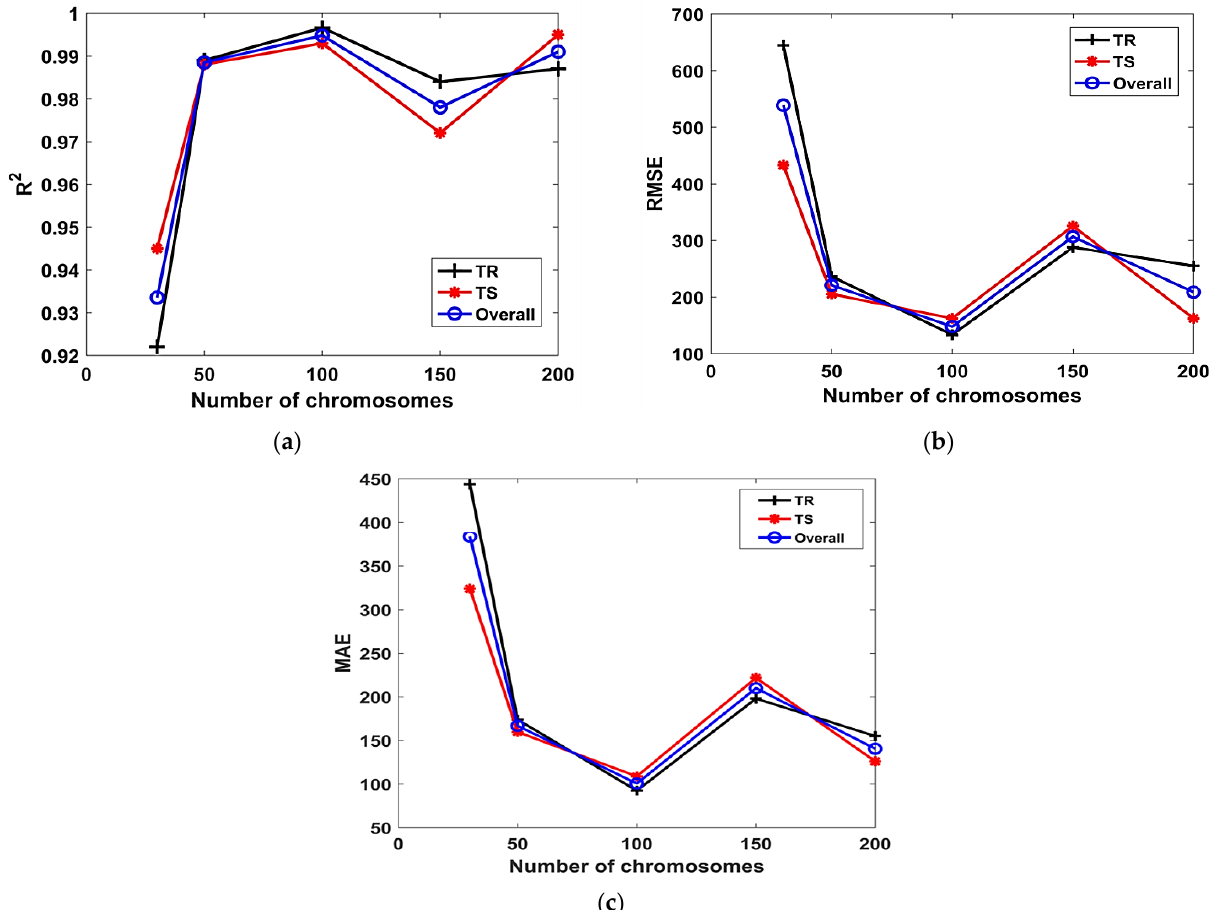
Figure 3. Effect of N c on the performance of models. ( a ) R 2 , ( b ) RMSE , ( c ) MAE .